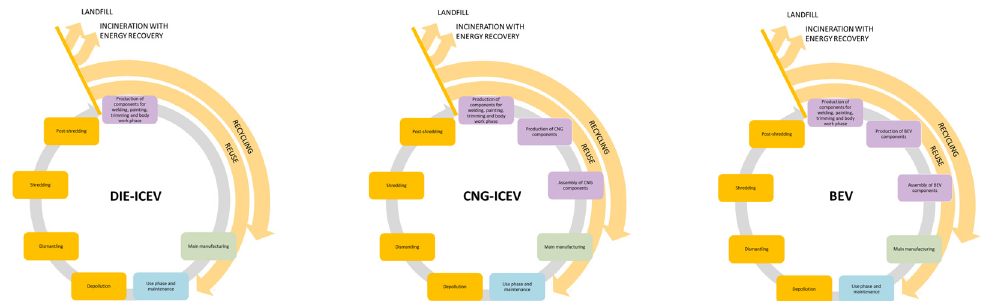
Figure 1. System boundary.